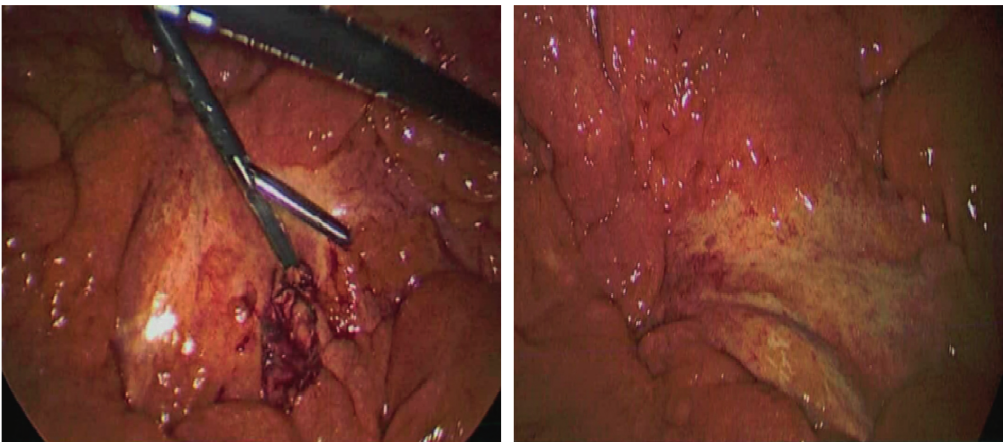
Figure 2: Mosaic white stranding of the mesentery in the proximal aspect in the areas involved on CT imaging. The bowel was hyperemic but obviously